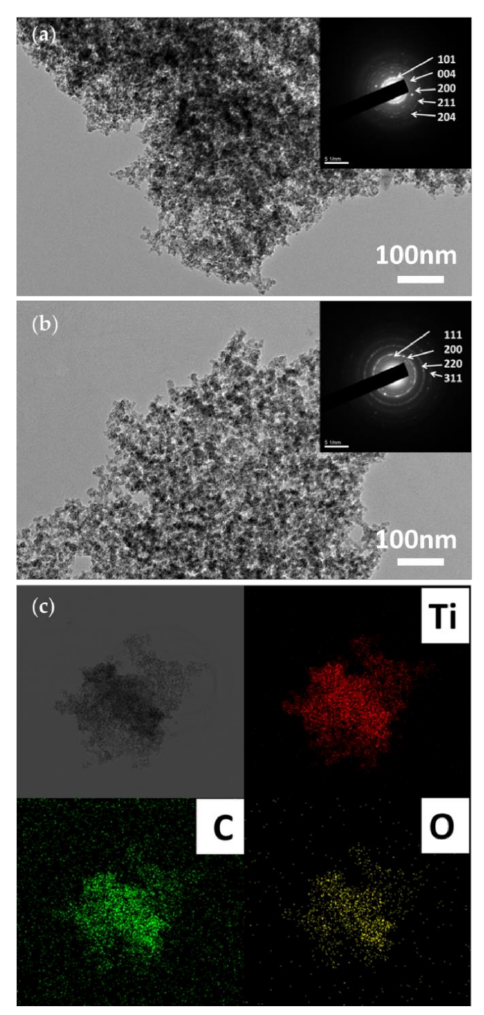
Figure 6. TEM images with SAED inset patterns of ( a ) C / TiO 2 aerogel and ( b ) TiC / C aerogel; ( c ) mapping results of TiC / C aerogel.